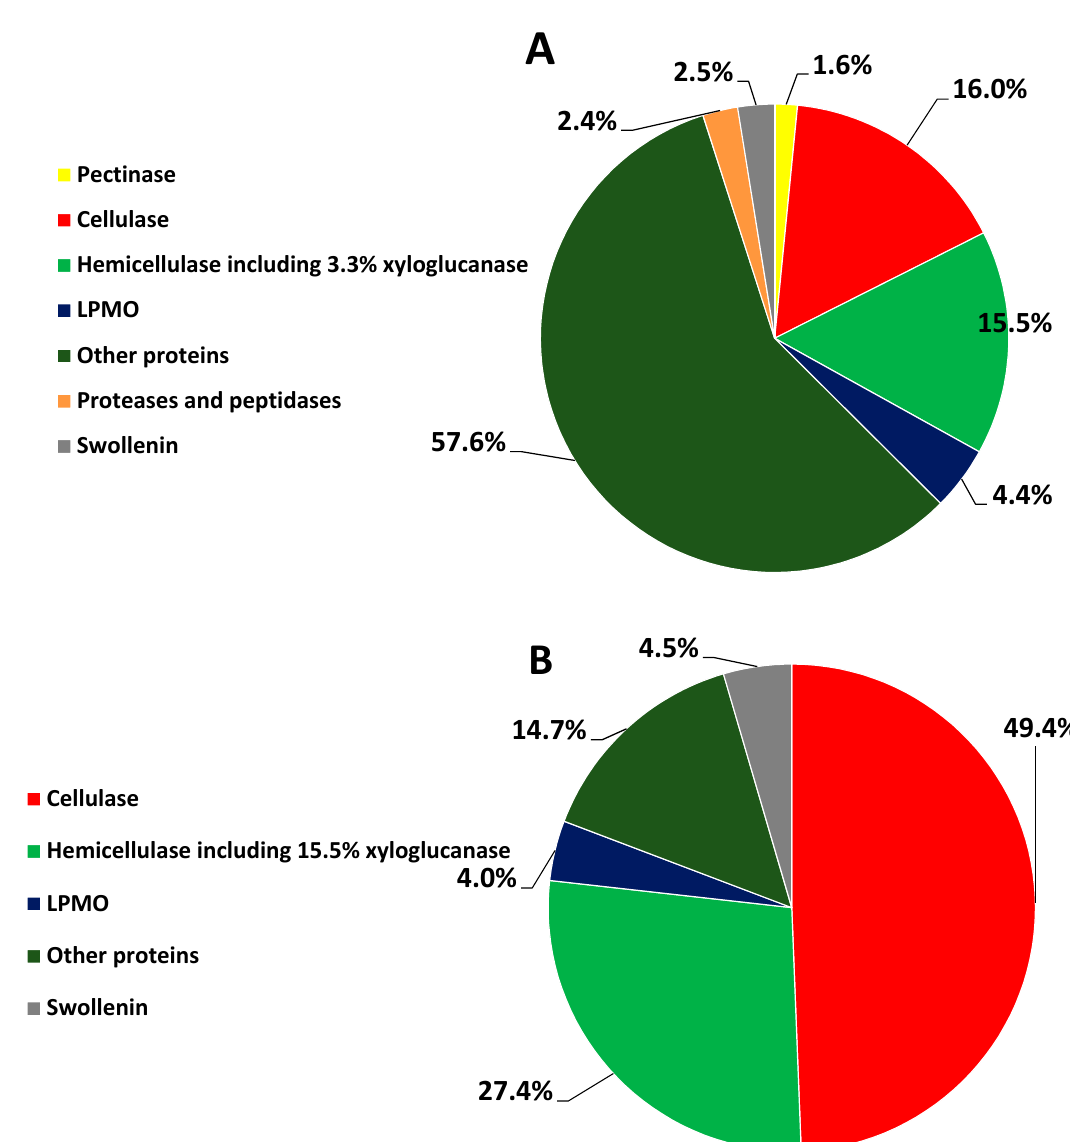
Figure 2. Percentage of the proteins identified in T. reesei Rut ‐ C30 ( A : C30WB; B : C30RS).